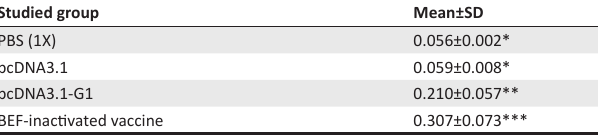
TABLE 1: Anti-G1 antibodies produced in mice after intramuscular inoculation of plasmids and bovine ephemeral fever-inactivated vaccine measured by enzyme-linked immunosorbent